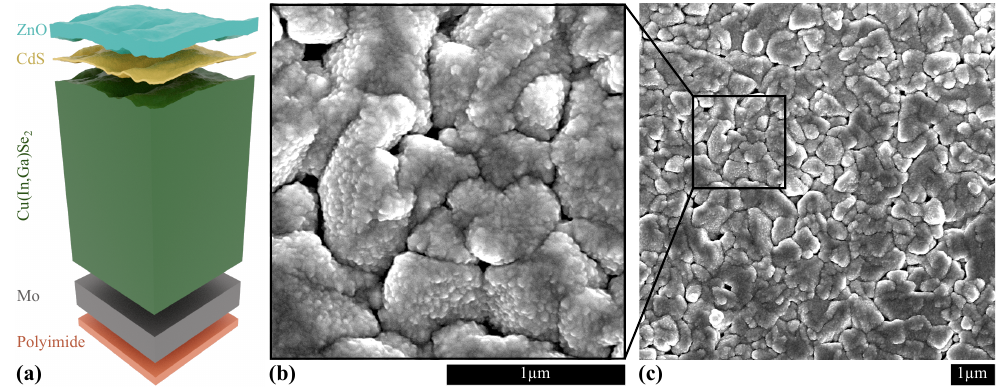
Figure 1. ( a ) Scheme of the Cu(In,Ga)Se 2 (CIGS) solar-cell stack. ( b , c ) Scanning electron microscopy image of the solar-cell surface (courtesy of A. Jeromin, DESY NanoLab [32]).